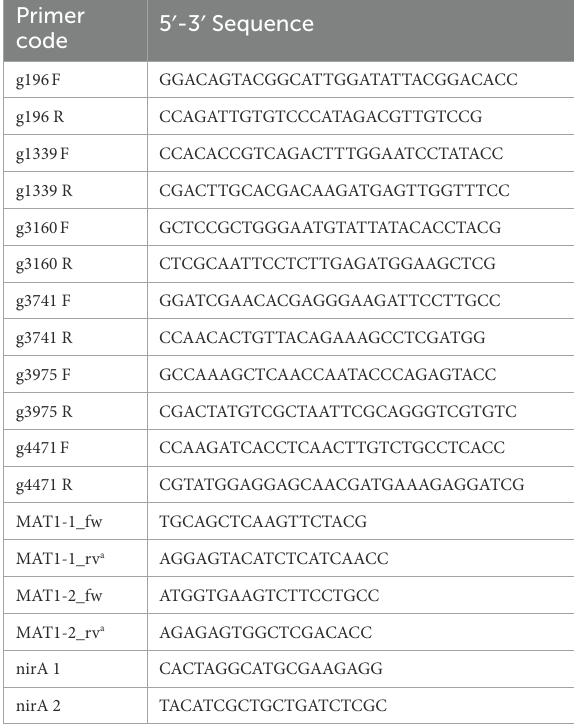
TABLE 2 List and nucleotide sequence of the oligonucleotides used in this work. Primer